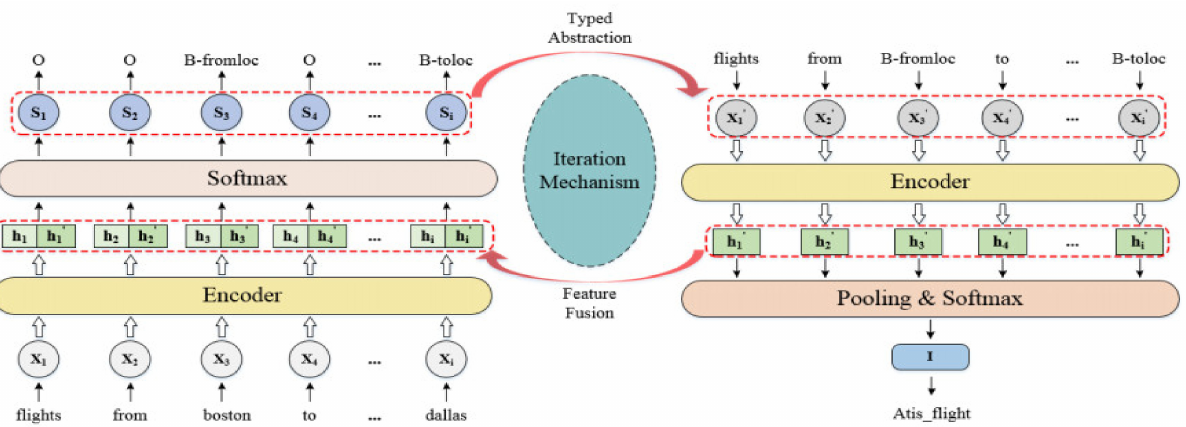
Figure 1. Illustration of our proposed approach. The red arrow indicates that the two subtasks are enhanced and interact through two different mechanisms. We use the same encoder to retain the characteristics of the joint model and use the iteration mechanism to ensure that the process of encoding information interaction is not affected by error propagation.